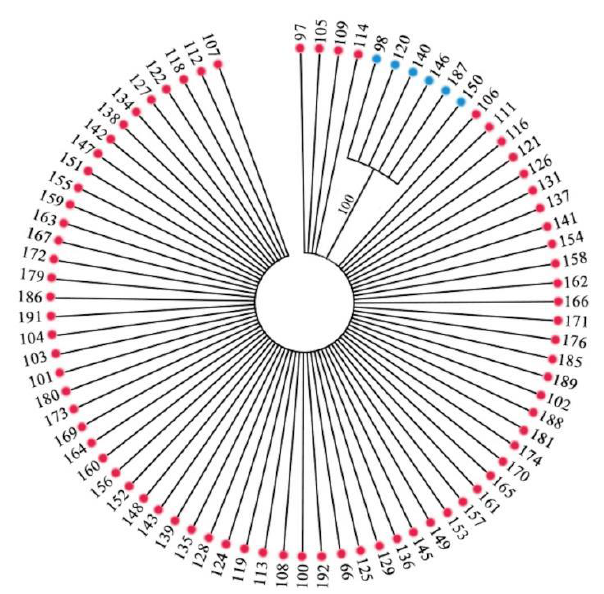
Figure 6. Strict consensus tree of 80 accessions using the Maximum Parsimony (MP) method (the numbers in the figure represent the number of the accessions).